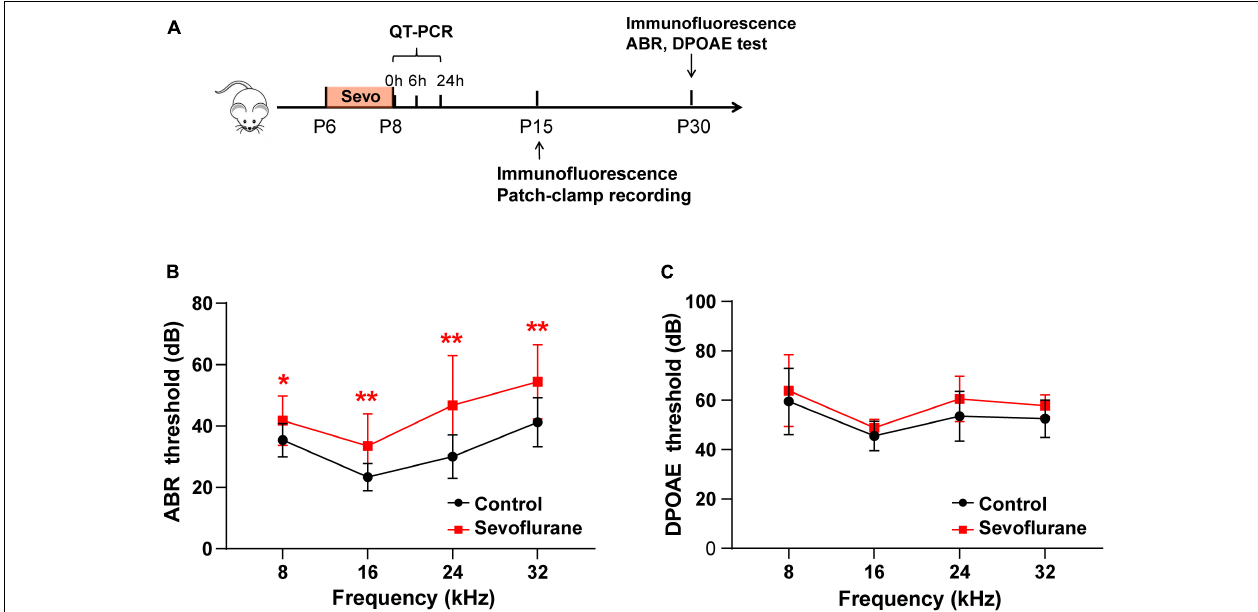
FIGURE 1 | Multiple sevoflurane exposures in naïve mice impair hearing function. (A) Timeline of the experimental protocol. (B) Compared to the control group, auditory brainstem response (ABR) thresholds in the sevoflurane group are significantly elevated at 8, 16, 24, and 32 kHz ( n = 12 in the control group, n = 17 in the sevoflurane group). (C) Distortion product otoacoustic emission (DPOAE) thresholds are comparable in both groups at different frequencies ( n = 10 control group, n = 9 sevoflurane group). * P < 0.05, ** P < 0.01, unpaired Student’s t -test.